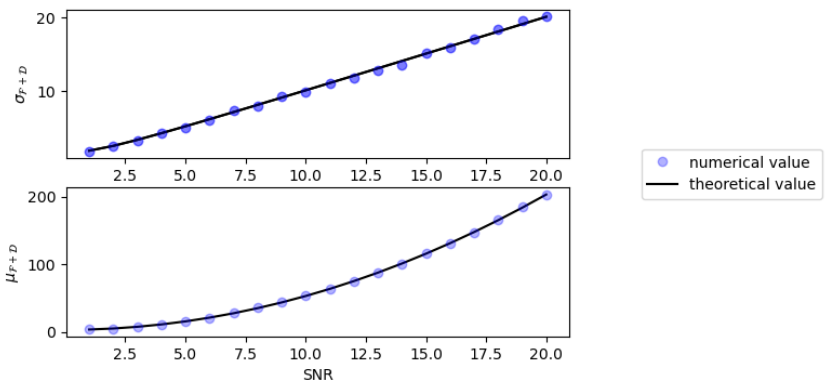
Figure 2. Simulated mean µ and standard deviation σ of the sum of F -statistic and D -statistic for an array of SNRs. Continuous lines are the theoretical predictions.